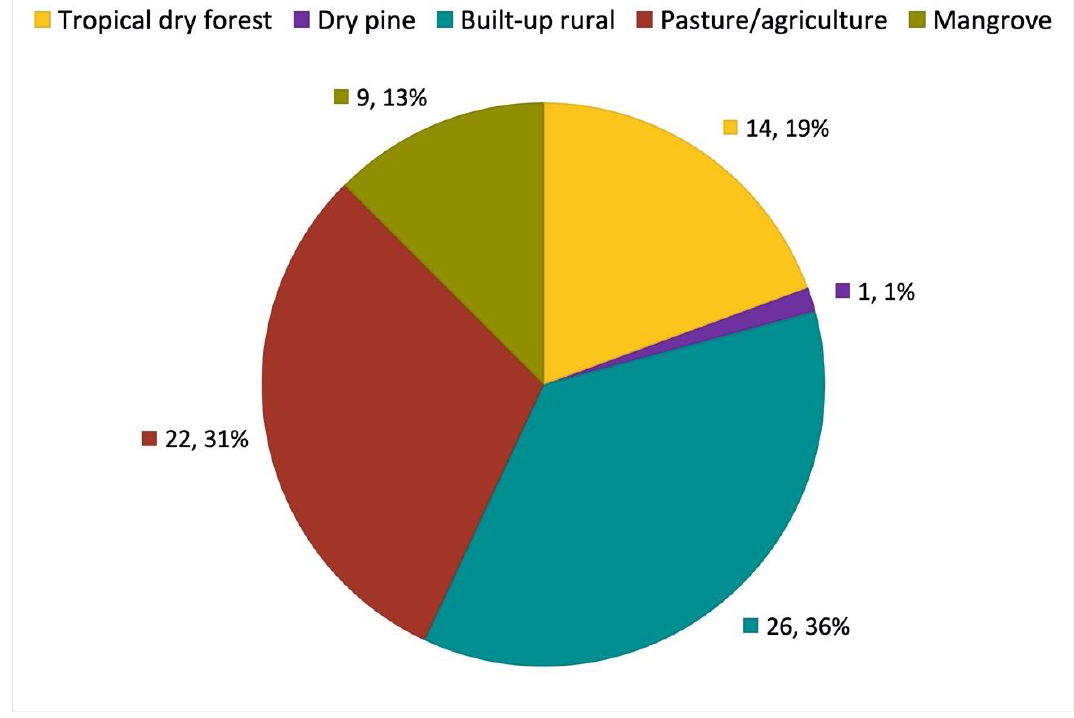
Figure 3. The proportion of yellow-naped amazon roosts in each of six habitat types (N = 72).